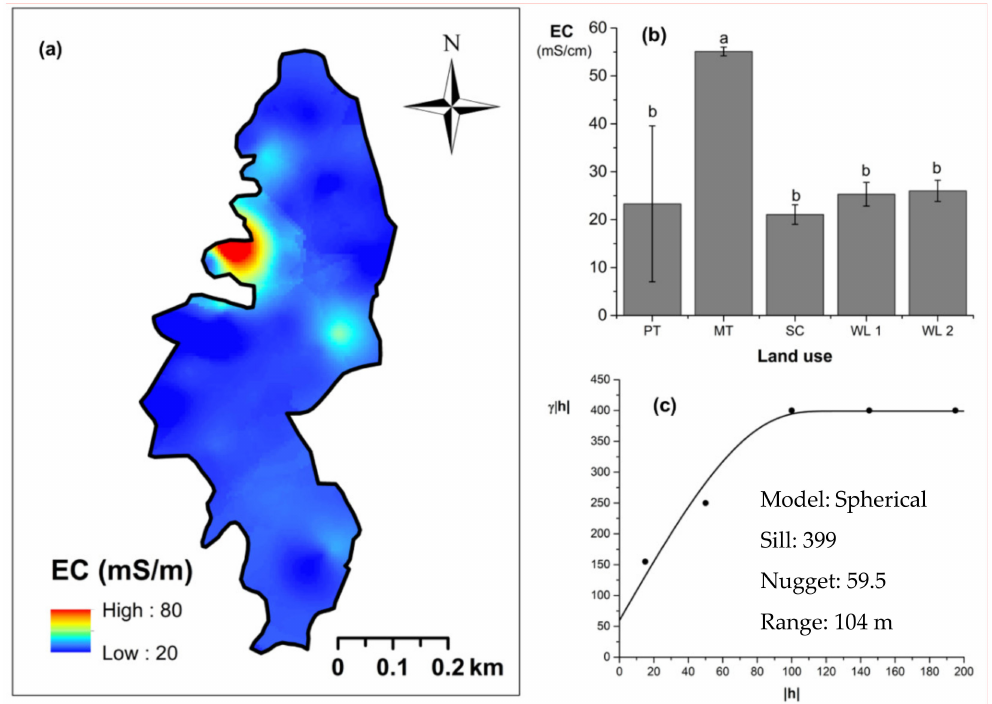
Figure 9. Spatial variability of soil electrical conductivity (EC): ( a ) map, ( b ) bar graph among different land uses (see Figure 1, label A for notations) in the Endane Biodiversity Corridor, and ( c ) variogram between lag distance and semivariance. Semivariance function: γ ( h ) = 59.5 + 5.755 h − 1.773 × 10 − 4 h 3 . Comparisons depicted by the different letters on the bars in subfigure ( b ) indicate significant pair-wise differences.